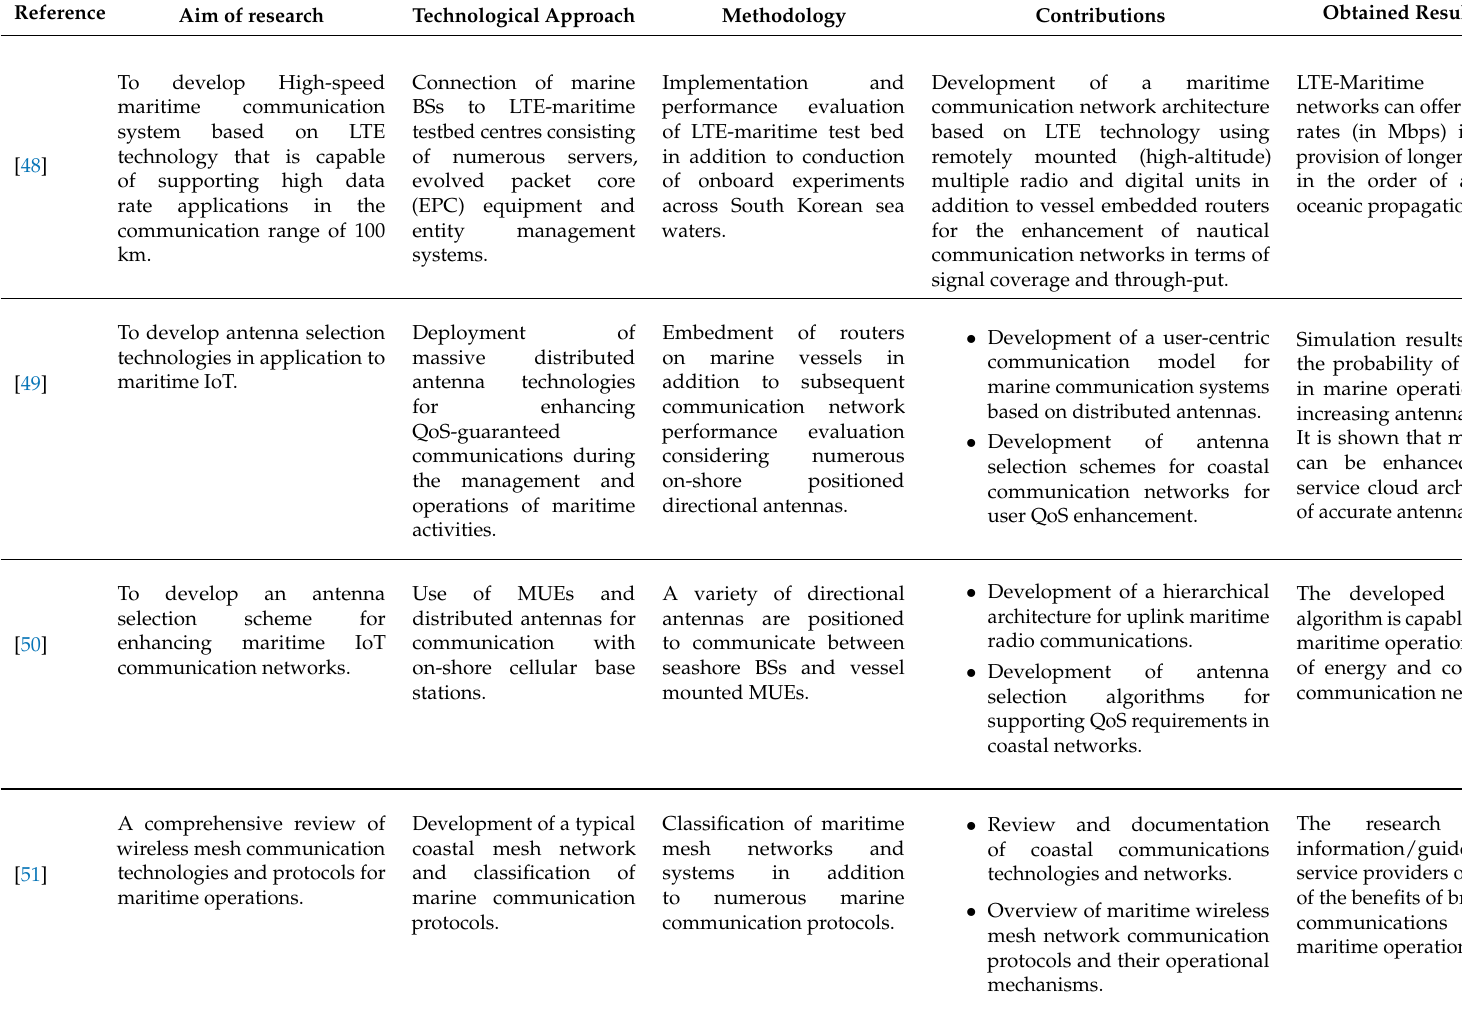
Table 2. Summary of Contemporary Research Works in the Maritime